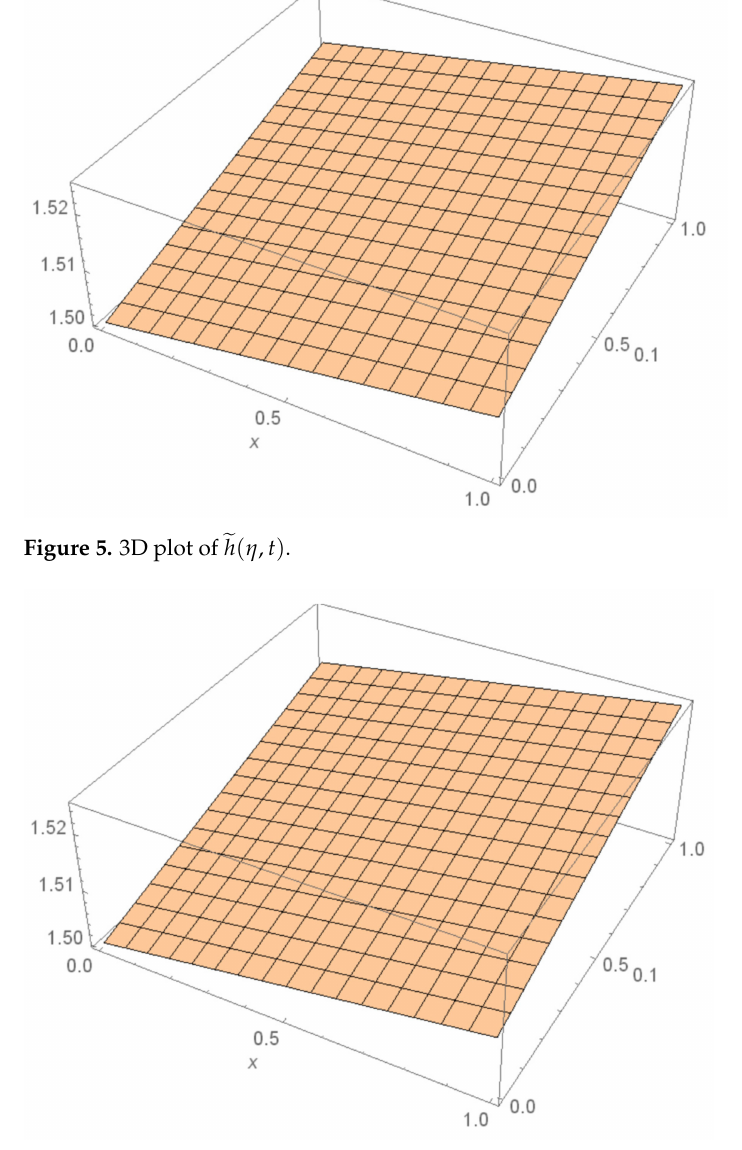
Figure 6. 3D plot of exact solution of h ( η , t ) .